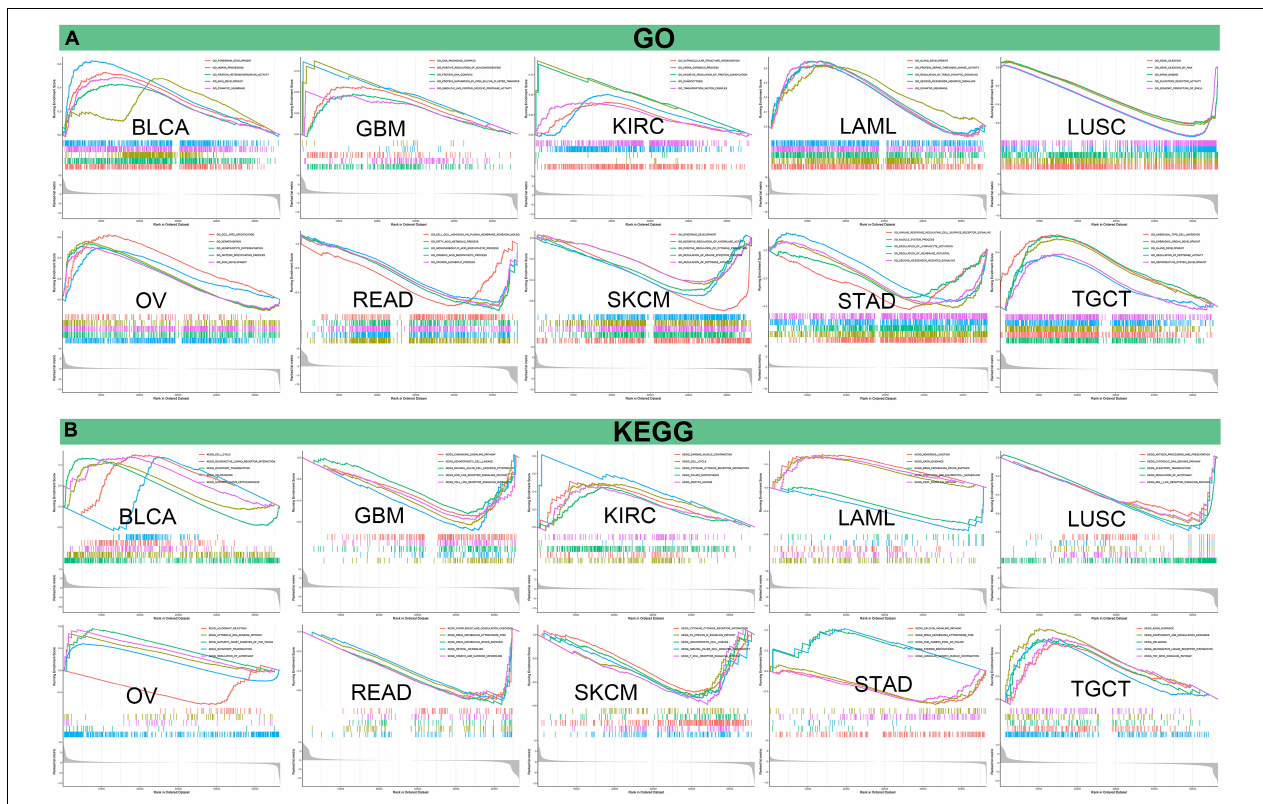
FIGURE 14 | Pathway analysis of PIMREG in various cancers. (A) GO functional annotations of PIMREG in tumors. (B) KEGG pathway analyses of PIMERG in various tumors. Curves with different colors represent that PIMREG regulates distinct functions or pathways of various tumors. Peaks of curves upward indicating positive regulation and peaks of curves downward representing negative